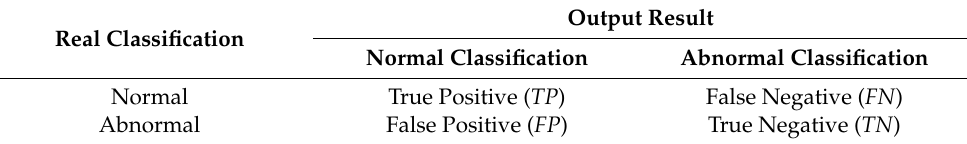
Table 2. Confusion matrix for classification